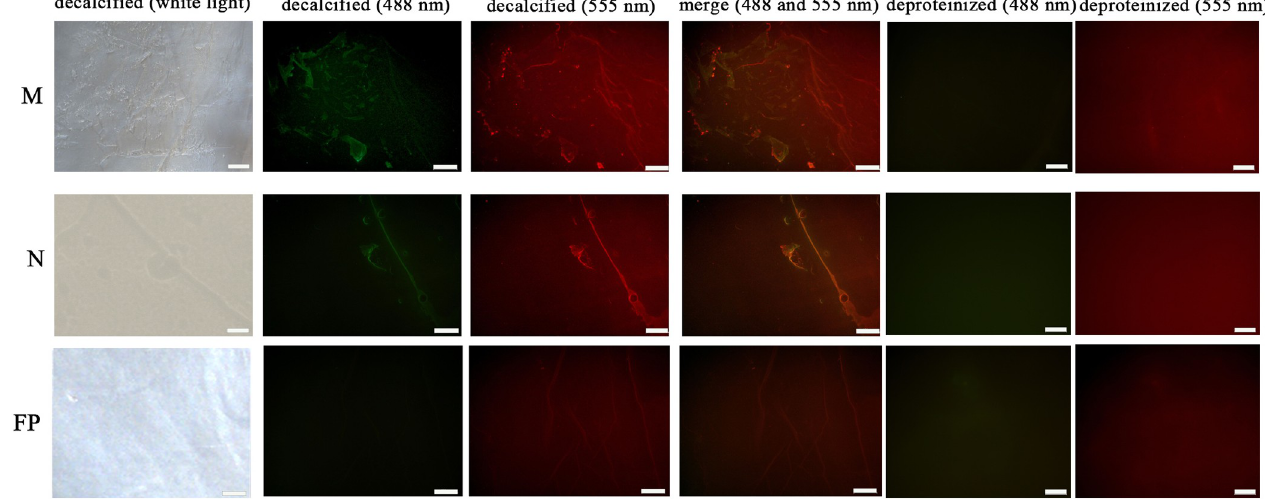
Fig 11. Immunofluorescence location of native WLP (green at 488 nm) and actin (red at 555 nm) on the surface of decalcified shell samples of M . coruscus and the deproteinized shell samples were used as negative controls. N, nacre; M, myostracum; FP, fibrous prism. The scale bar, 100 μ m.